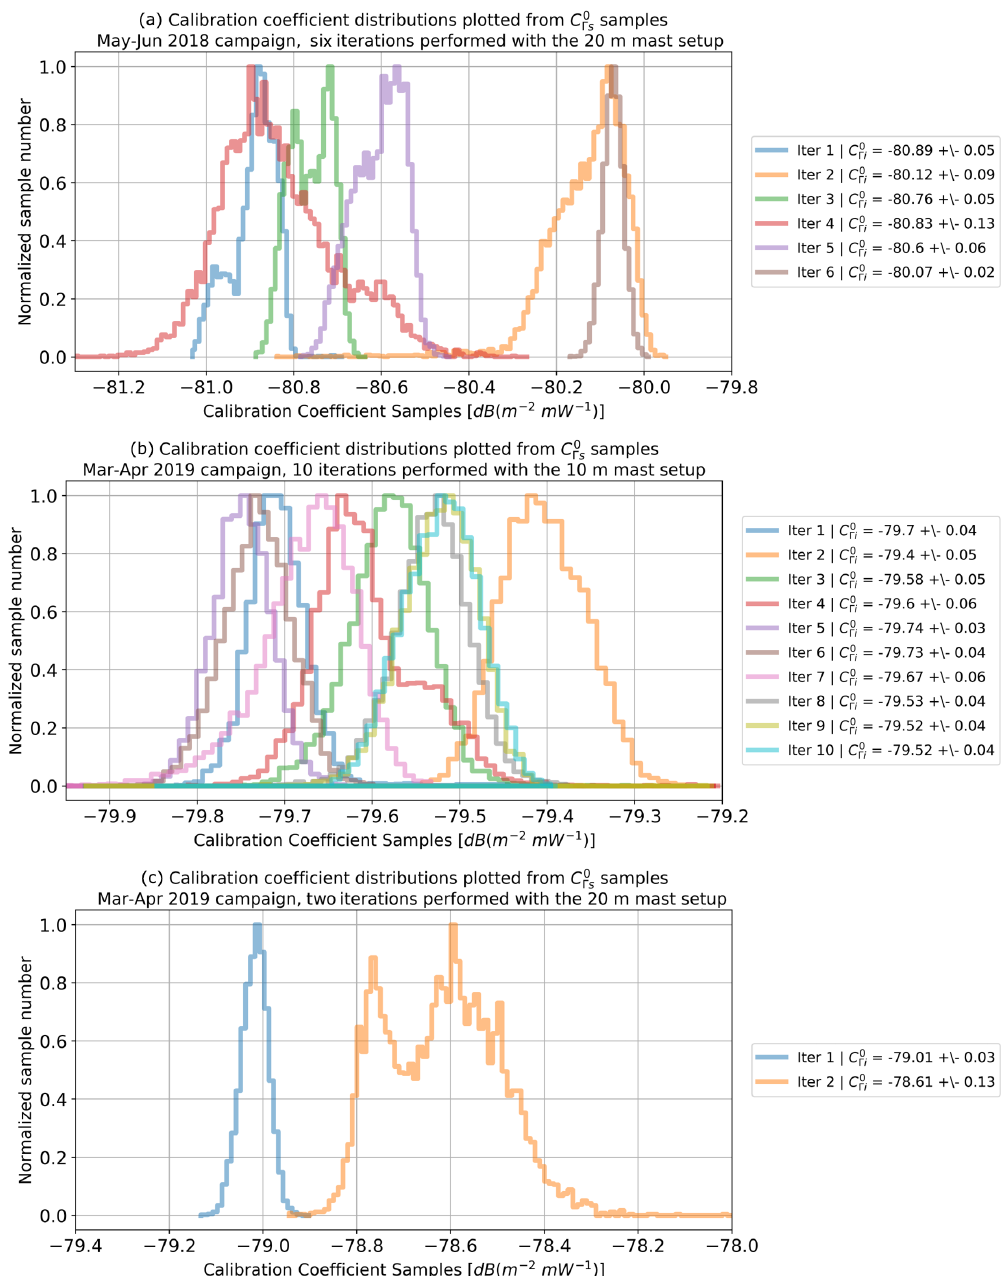
Figure 10. Calibration coefficient distributions obtained for the (a) 2018 campaign using the 20cm target on the 20m mast, the (b) 2019 campaign using the 10cm target on the 10m mast and the (c) 2019 campaign with the 20cm target on the 20m